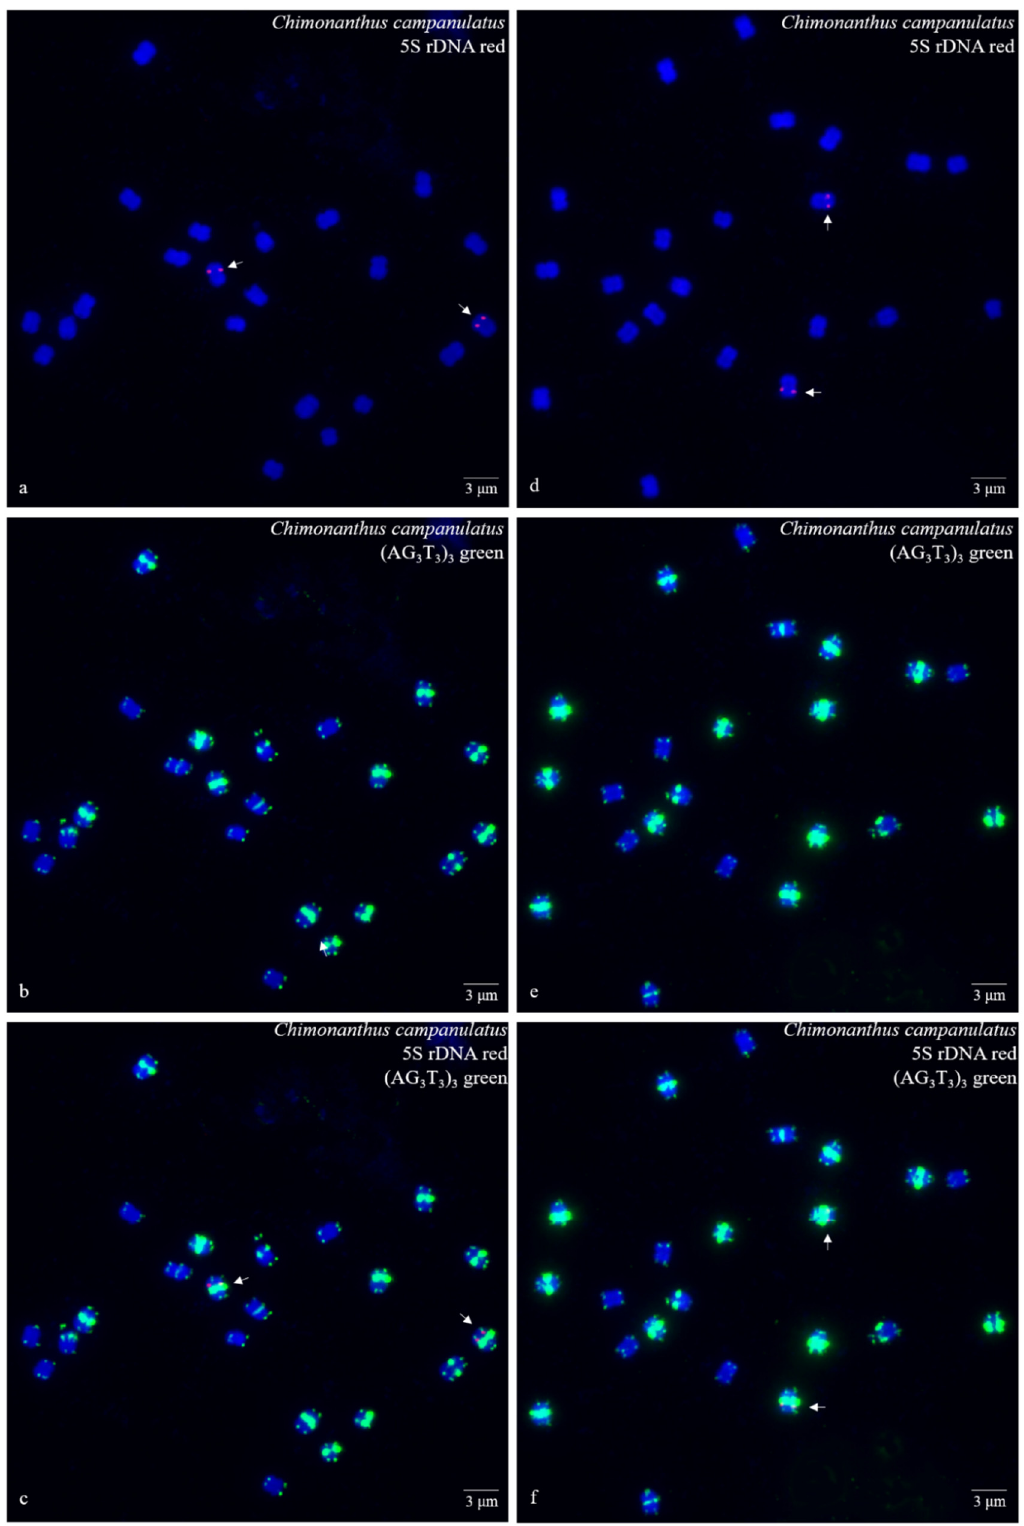
Figure 3. Mitotic metaphase (further development stage) chromosomes of Chimonanthus campanulatus after FISH. Two spreads are presented in Figure 3 a – c and Figure 3 d – f . The probe oligo-5S rDNA result with chromosomes visualized by TAMRA (red, white arrows) is shown in Figure 3 a , c , d , f , whereas the probe oligo – (AG 3 T 3 ) 3 result with chromosomes visualized by FAM (green) is shown in Figure 3 b , c , e , f . Chromosomes were counterstained by DAPI (blue) in all images. Scale bar = 3 μ M.